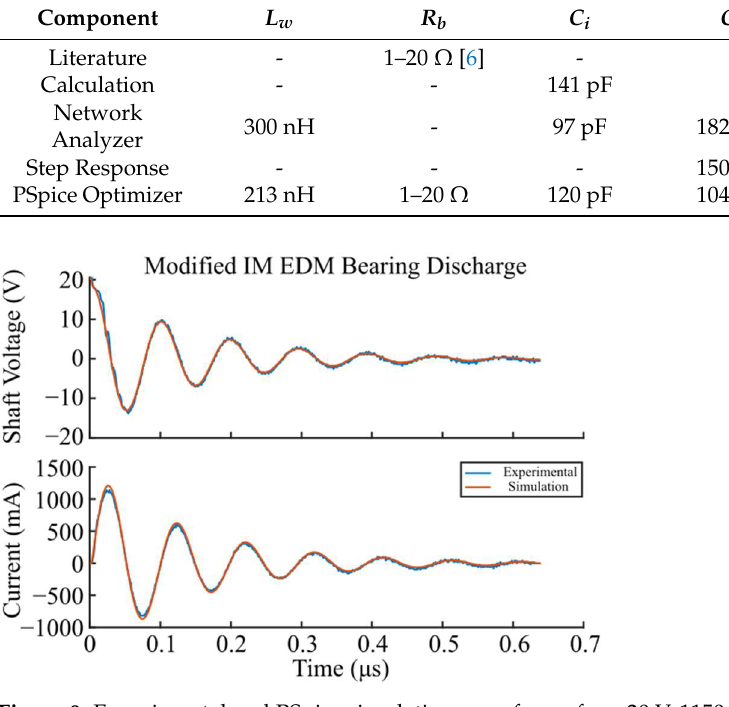
Figure 10. A 23 V shaft voltage discharge that takes ~17 ns to discharge on the unmodified IM.